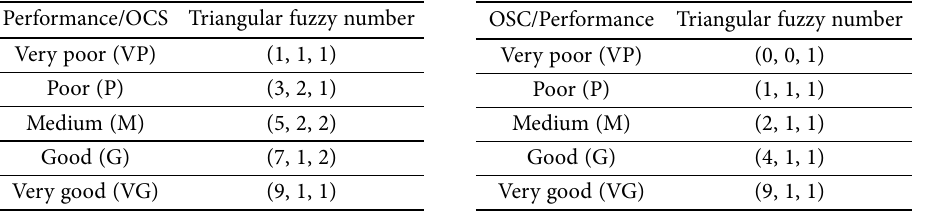
Table 4. Linguistic variables-drastic